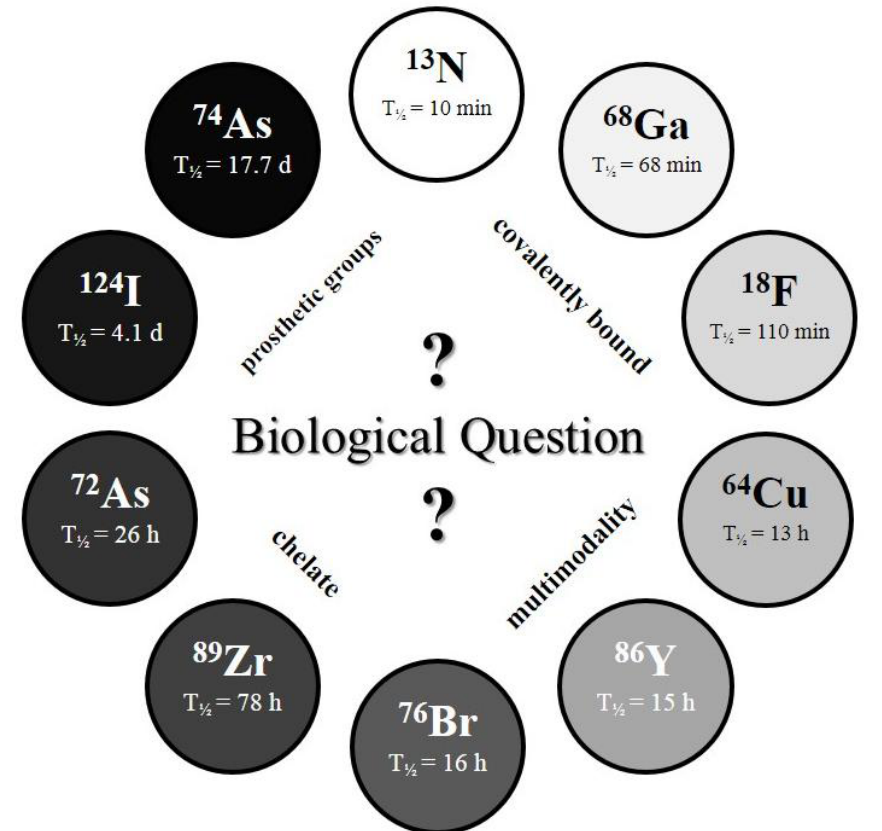
Figure 2. The Clock-Of-Nuclides showing the positron emitters used for radiolabeling of NPs or polymers, so far. Clockwise starting at 13 N (at noon) with the shortest physical half-life and ending at 74 As with the longest physical